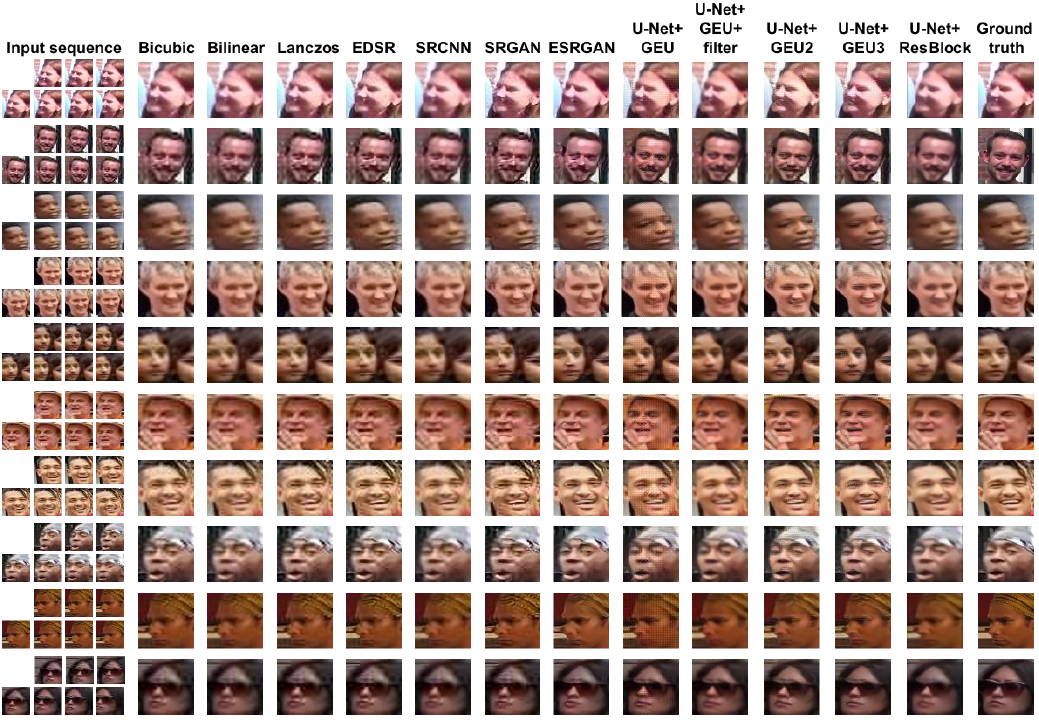
Figure 10. Examples of the resulting methods. All seven 32 × 32px images of the input sequence were used for the multi-frame methods and the 4th image for single-frame approaches was